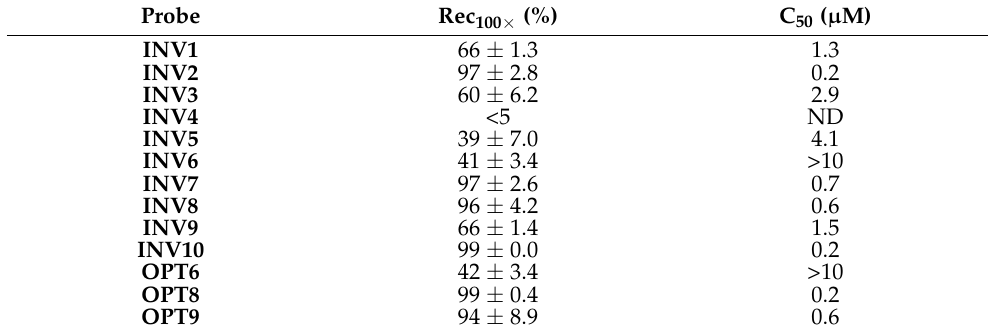
Table 3. Rec 100 × and C 50 values for recognition of model DNA hairpin targets when using the corresponding Invader probes a